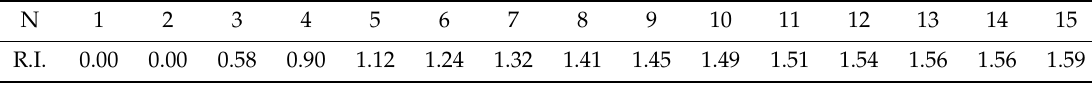
Table 2. Values of random inconsistency index (RI) for n =